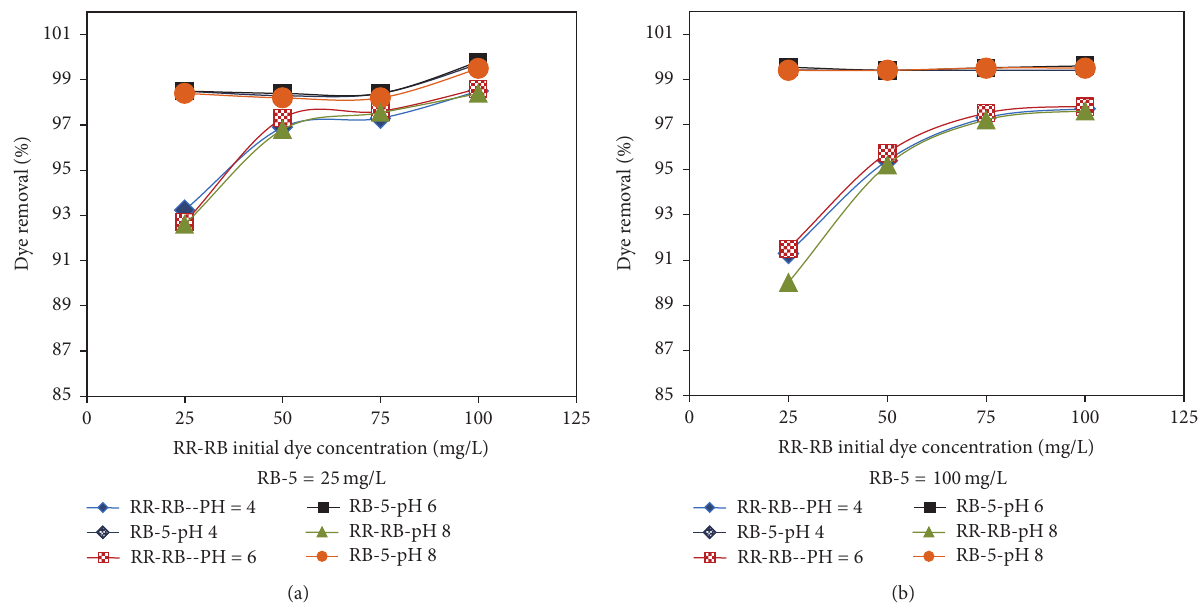
Figure 5: Effect of initial RR-RB dye concentrations on the removal percentages of RR-RB dye by QKCF at different pH in the presence of (a) 25 mg/L of RB-5 dye and (b) 100 mg/L of RB-5 dye (QKCF dosage = 0.1g/100 mL, agitation speed = 200 rpm, time = 4hr., and temp. = 25 ∘